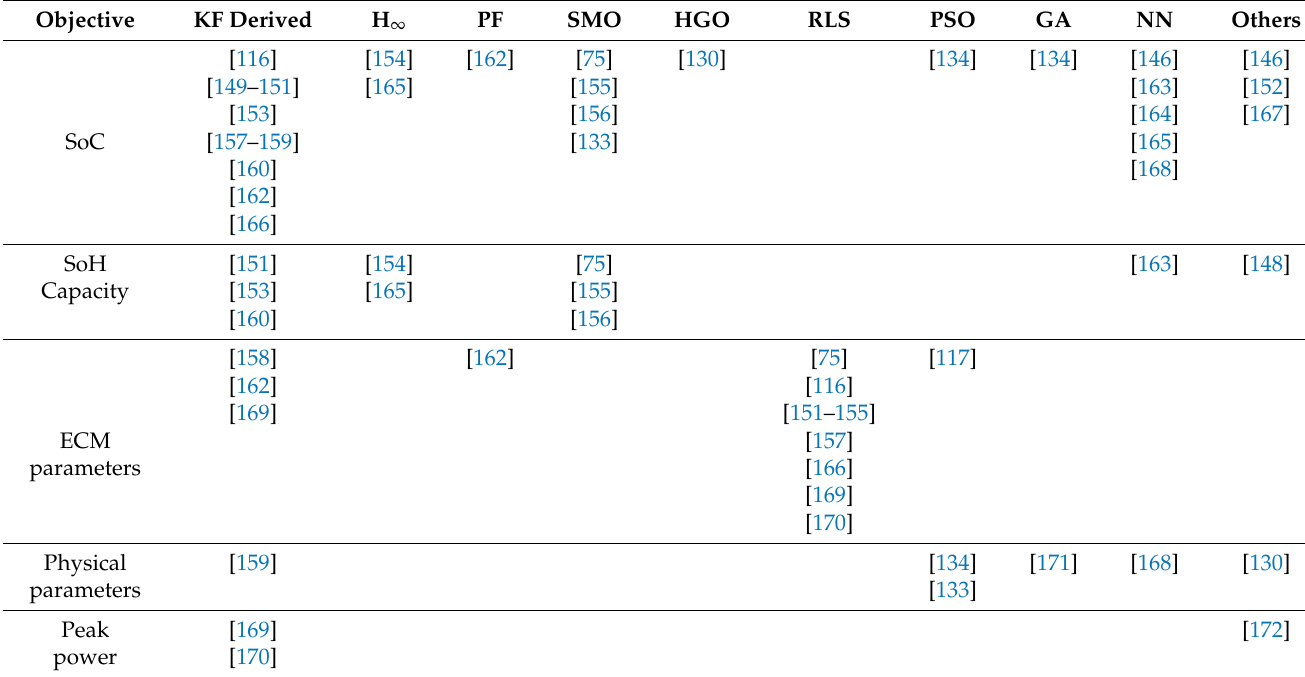
Table 4. Literature on VRFB